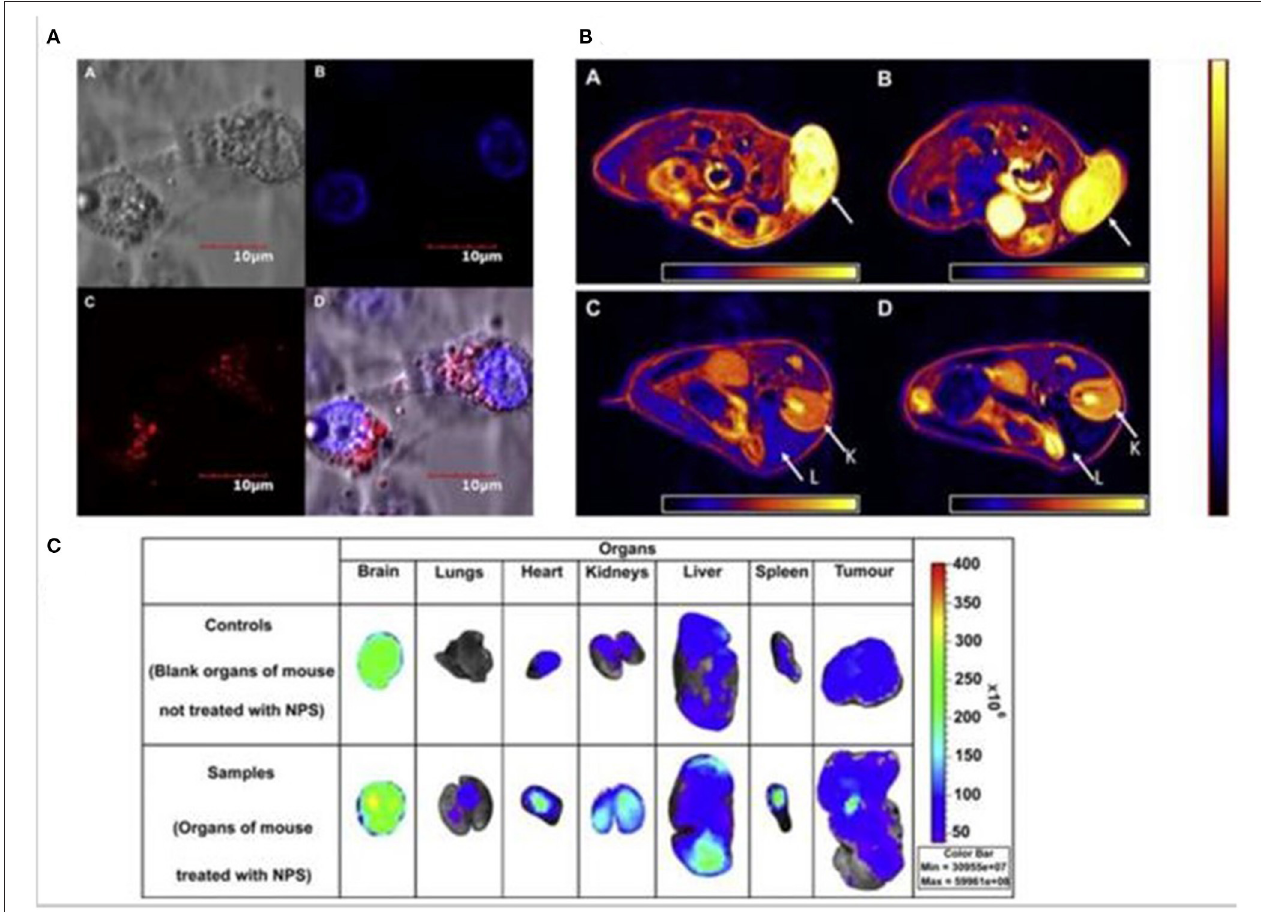
FIGURE 4 | Multi-modal imaging nanoparticles (A) Confocal photographs of PLA-TPGS nanoparticles with quantum dots and iron oxides processed in vitro with MCF-7. (B) MCF 7-graphed tumor-bearing mouse portions of axial MRI photographs. (C) Pictures under fluorescent light of various organs. The arrow shows the intensity of the confocol